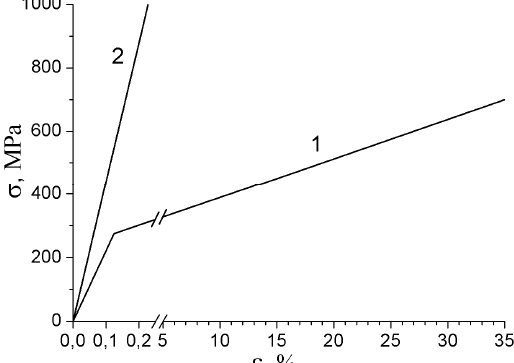
Figure 11: Mechanical response function of movable cellular automata for modelling (Ni-Cr)-alloy (1) and titanium carbide TiC